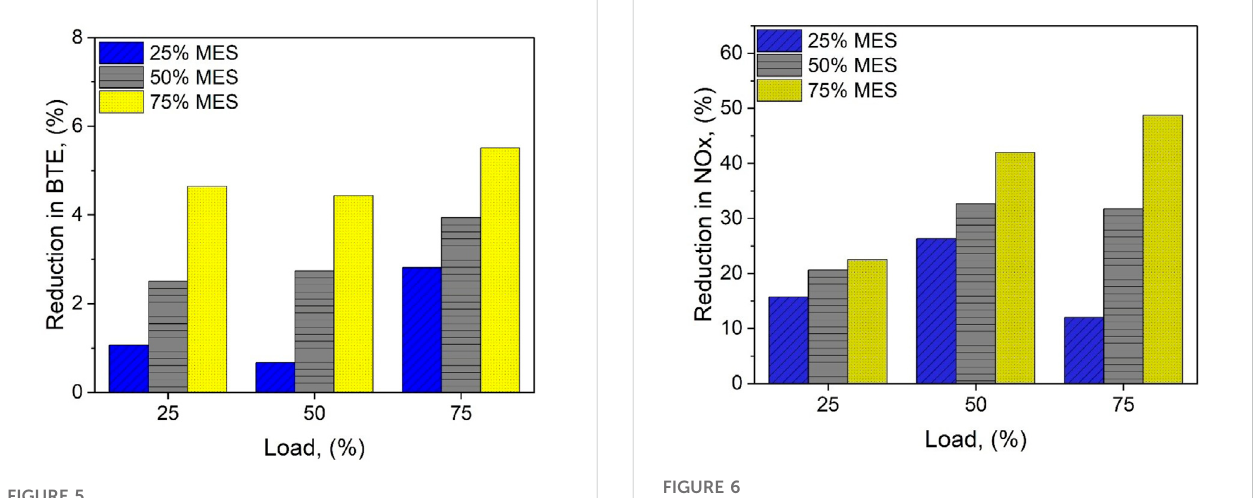
FIGURE 5 Percentage decrease in BTE with respect to diesel fuel with MES level at different loads.